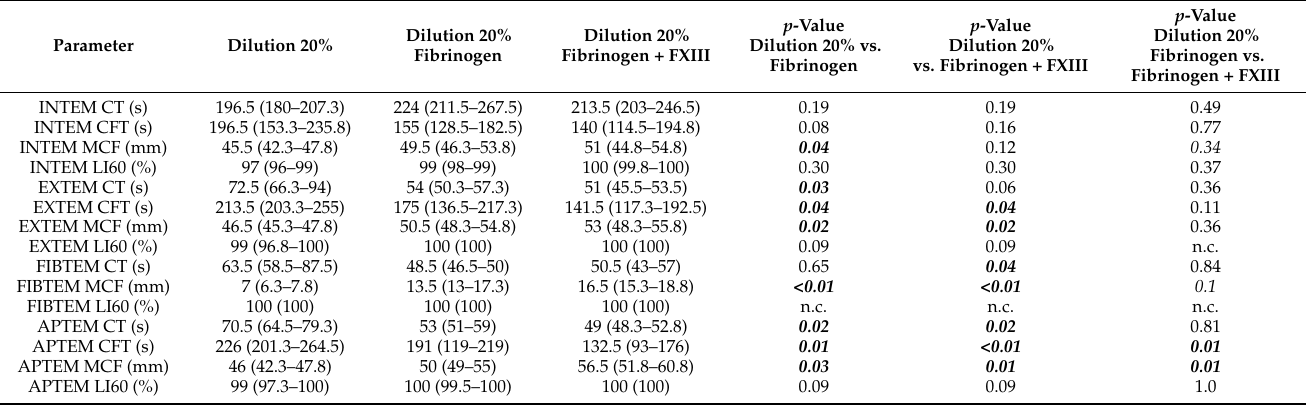
Table 2. Treatment of blood samples that were diluted by 20% and treated either with fibrinogen or combined fibrino- gen/FXIII.